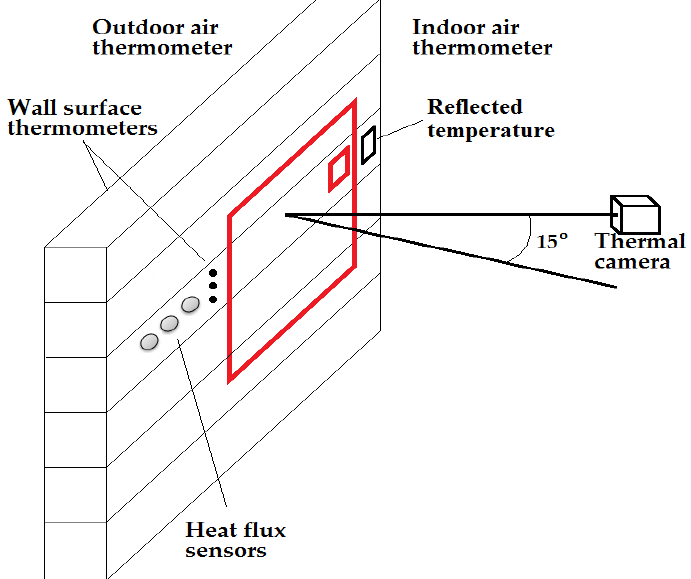
Figure 2. Experiment settings on a massive wood wall element including the locations of the sensors and the thermal camera. Each thermal image includes measurements of the reflection temperature (small black square) and the surface temperature of the large wall segment (large red square) and the small wall segment (small red square).